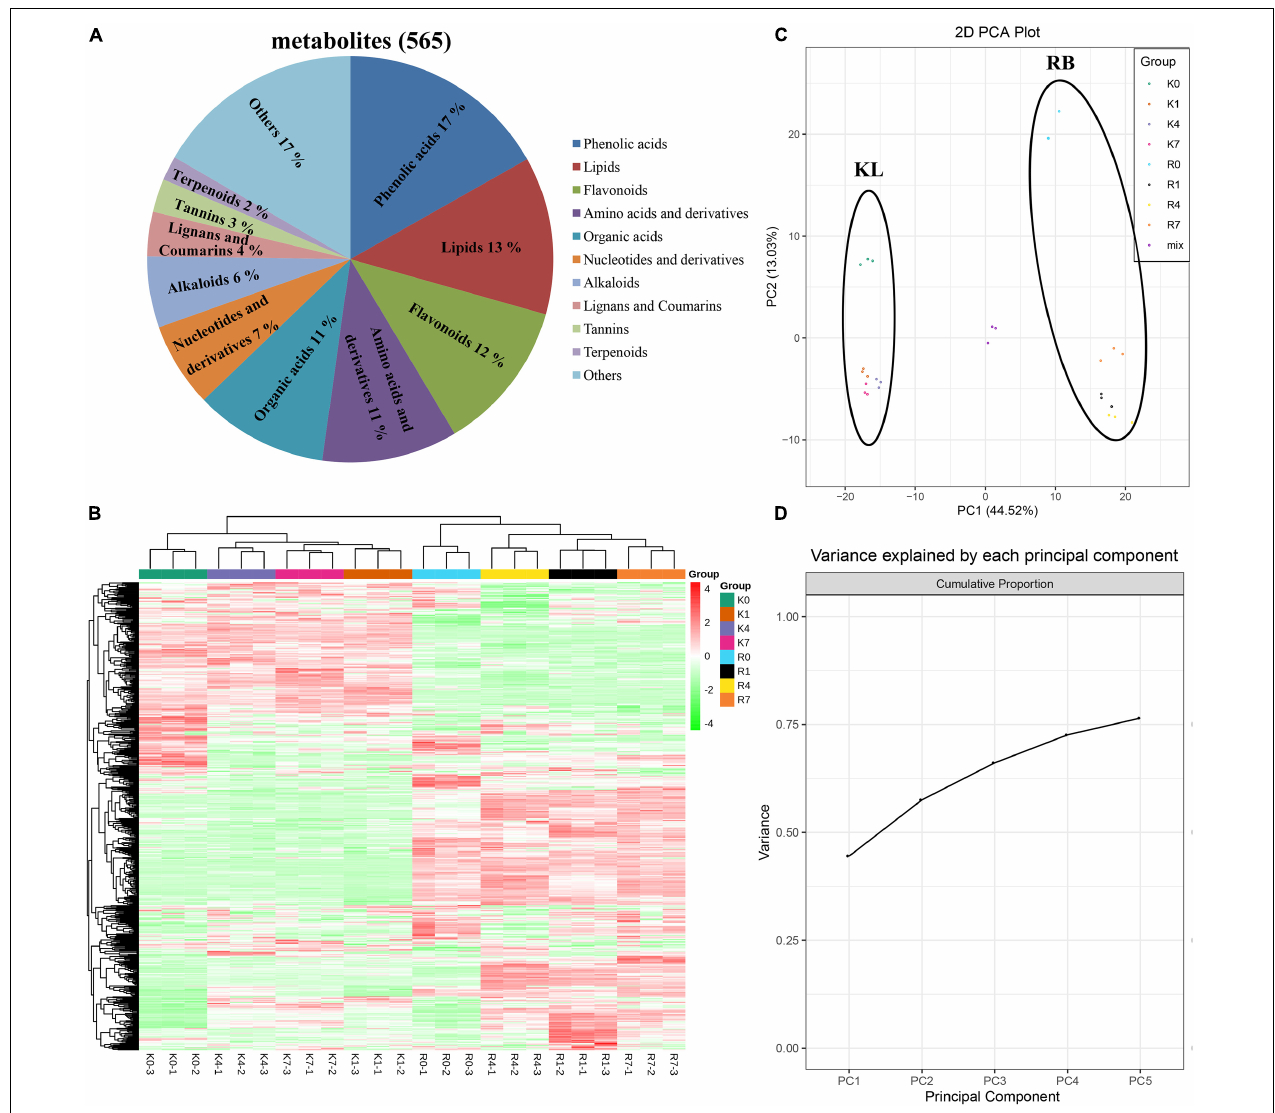
FIGURE 3 | Overview and analysis of metabolites according to UPLC-ESI-MS/MS. (A) Classification of the 565 metabolites. (B) Clustering heat map of all metabolites. (C,D) PCA results. Score plot: the abscissa and the ordinate represented the scores of PC1 and PC2, respectively; the left ring represents KL, and the right ring represents RB. Cumulation plot: variance explained by PC1, PC2, PC3, PC4, and